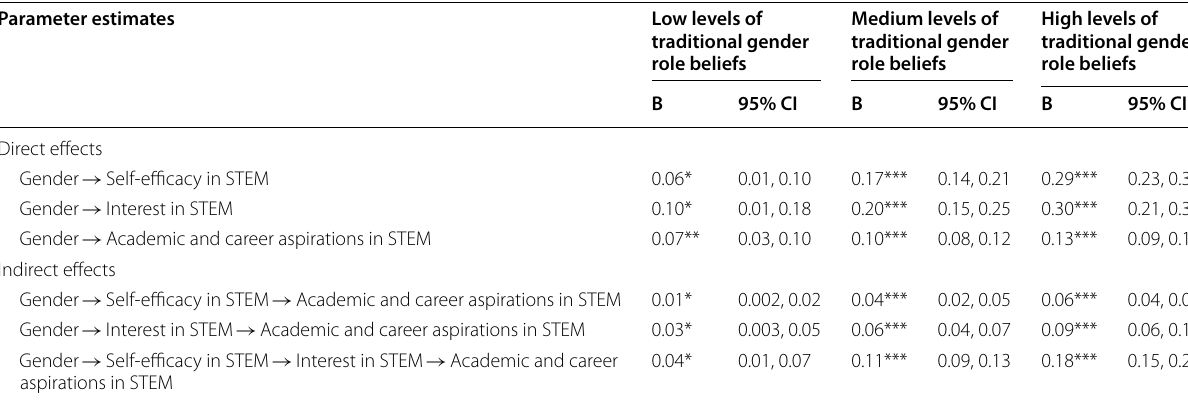
Table 4 Conditional effects of gender at low, medium, and high levels of traditional gender role beliefs